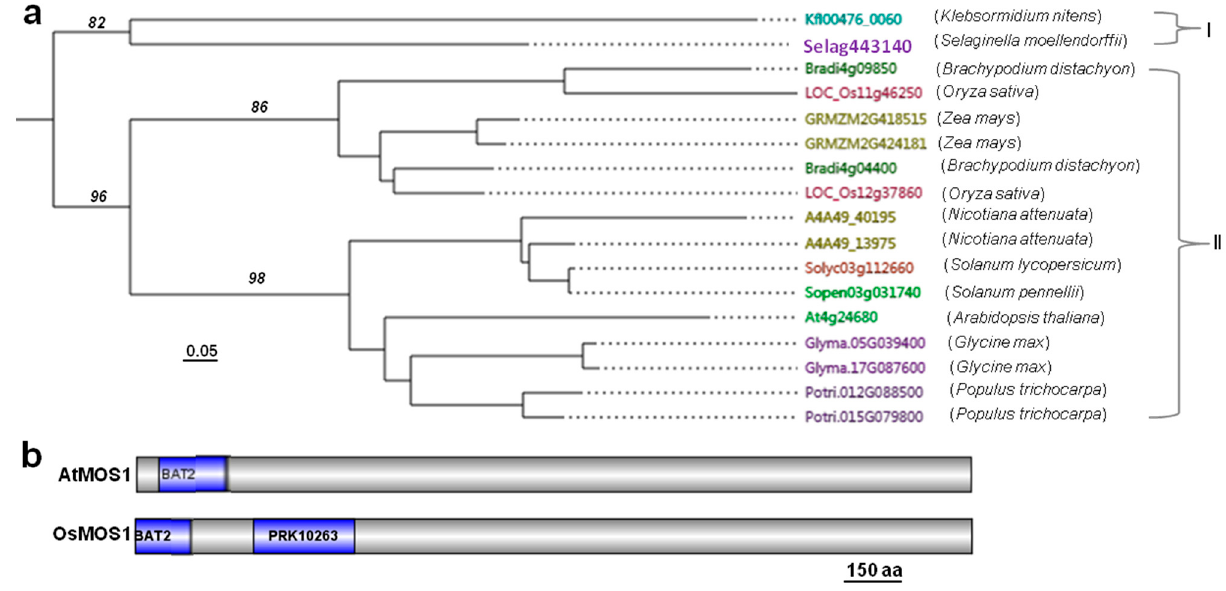
Figure 1. Homology analysis of MOS1. ( a ) Phylogenetic tree of MOS1 proteins from 12 plant species. The tree was constructed by using MEGA6.06 software based on the MOS1 protein sequences from the National Coalition Building Institute (2 March 2019, NCBI, https://www.ncbi.nlm.nih.gov/). The scale bar indicates the branch length. ( b ) Protein structures of AtMOS1 and OsMOS1. PRK10263 (DNA Translocase FtsK domain).